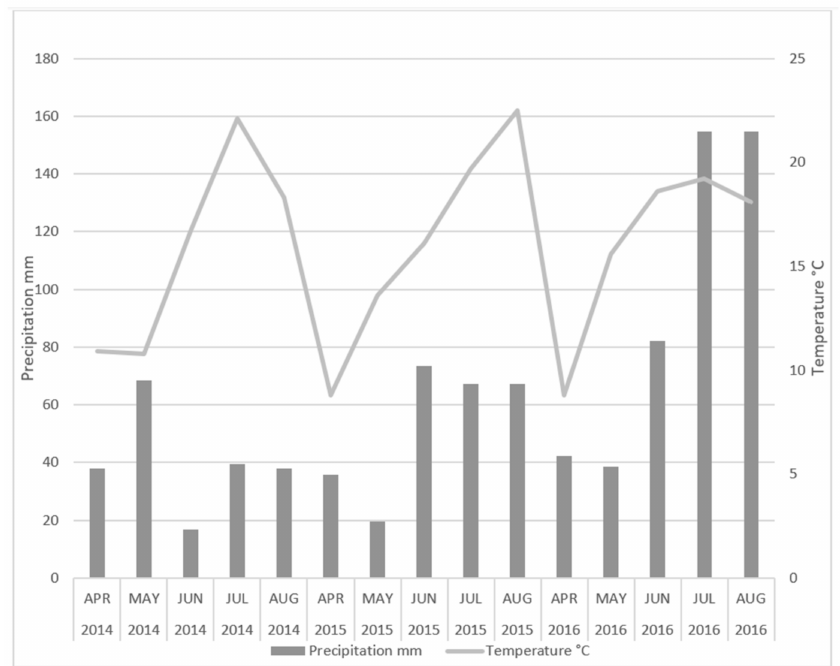
Figure 2. Monthly mean air temperature and total precipitation at the Pierzchno Meteorological